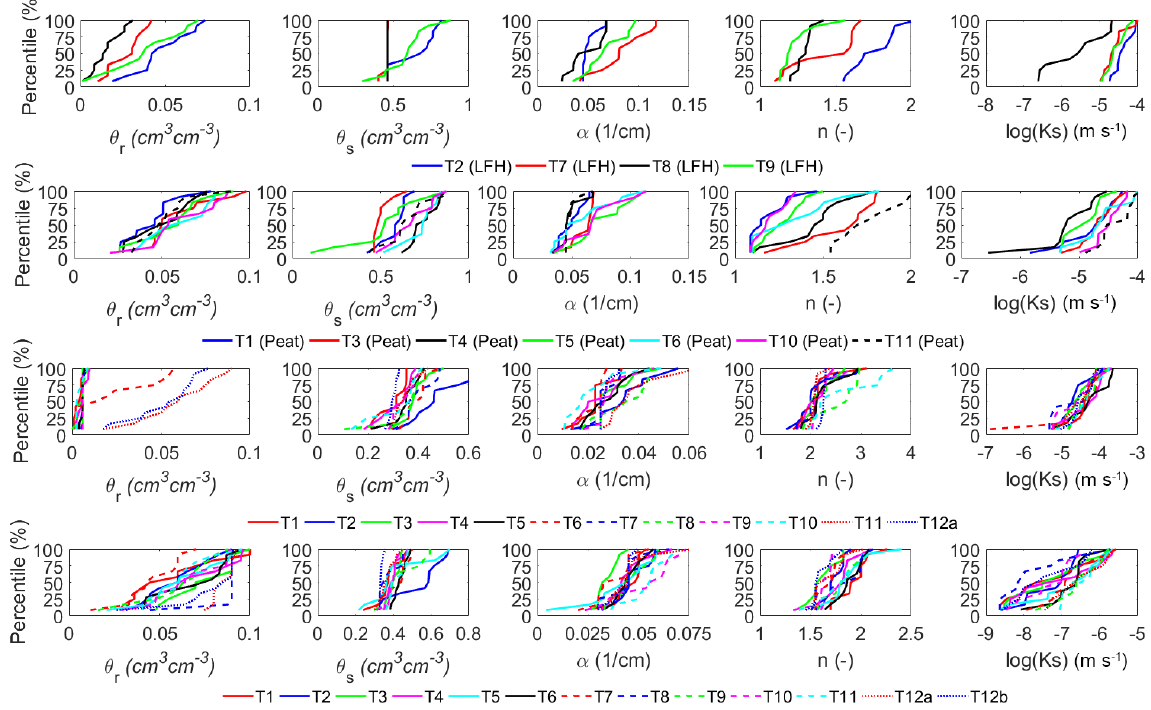
Figure A1. Frequency distributions of the optimized parameters for LFH (top row), peat (second row), subsoil (third row), and LOS (bottom row)